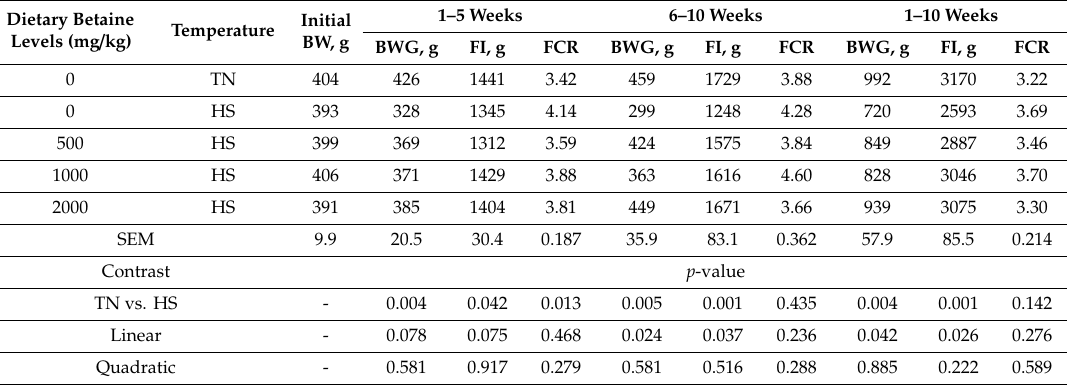
Table 2. E ff ects of heat stress and dietary betaine on growth performance of yellow-feathered broilers *. Dietary Betaine Initial Temperature Levels (mg / kg) BW,